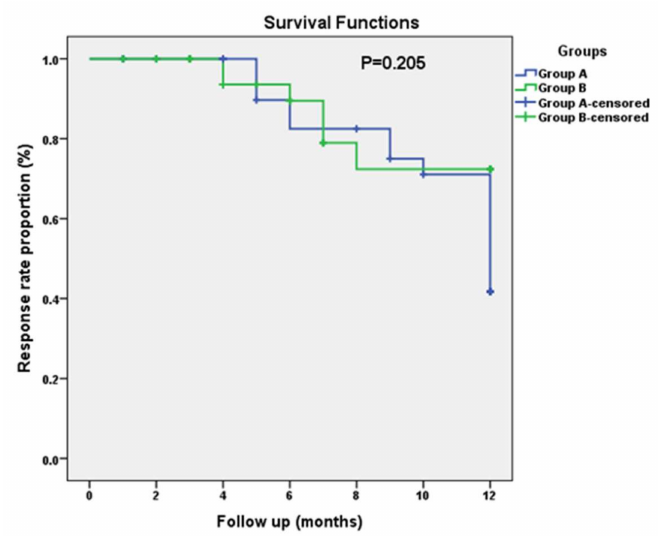
Figure 4. Kaplan–Meier curves for response rate among both studied